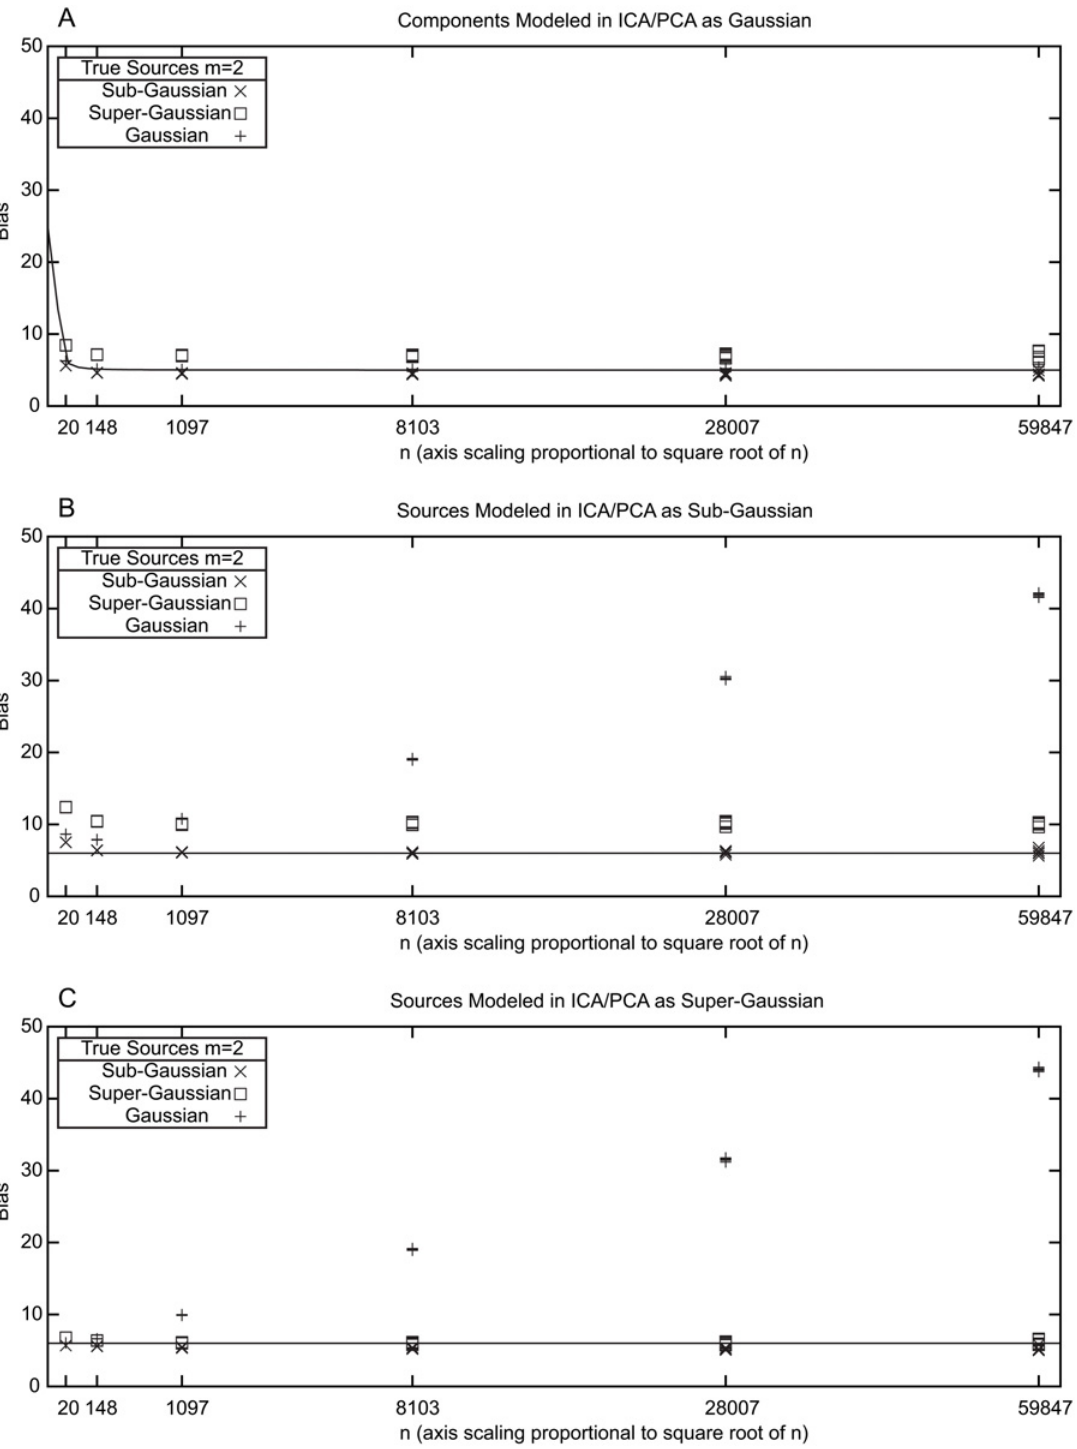
Fig 2. Estimation of T ^ n bias in simulated data. Each plotted data point represents one million simulations and five such points are plotted for each model. In each simulation, m was two and the value of n is shown on the x-axis. Sampling along the x-axis is logarithmic but the scaling is proportional to biases were calculated by first solving for W using a set of n random deviates from the designated true source distribution and comparing the resulting log likelihood with the log likelihood estimated from a new independent set of n random deviates from the same distribution using the value of W derived from the first set. A. Results with both sources modeled as Gaussian. The solid line shows predicted results based on Fujikoshi and Satoh (1997). B. Results with both